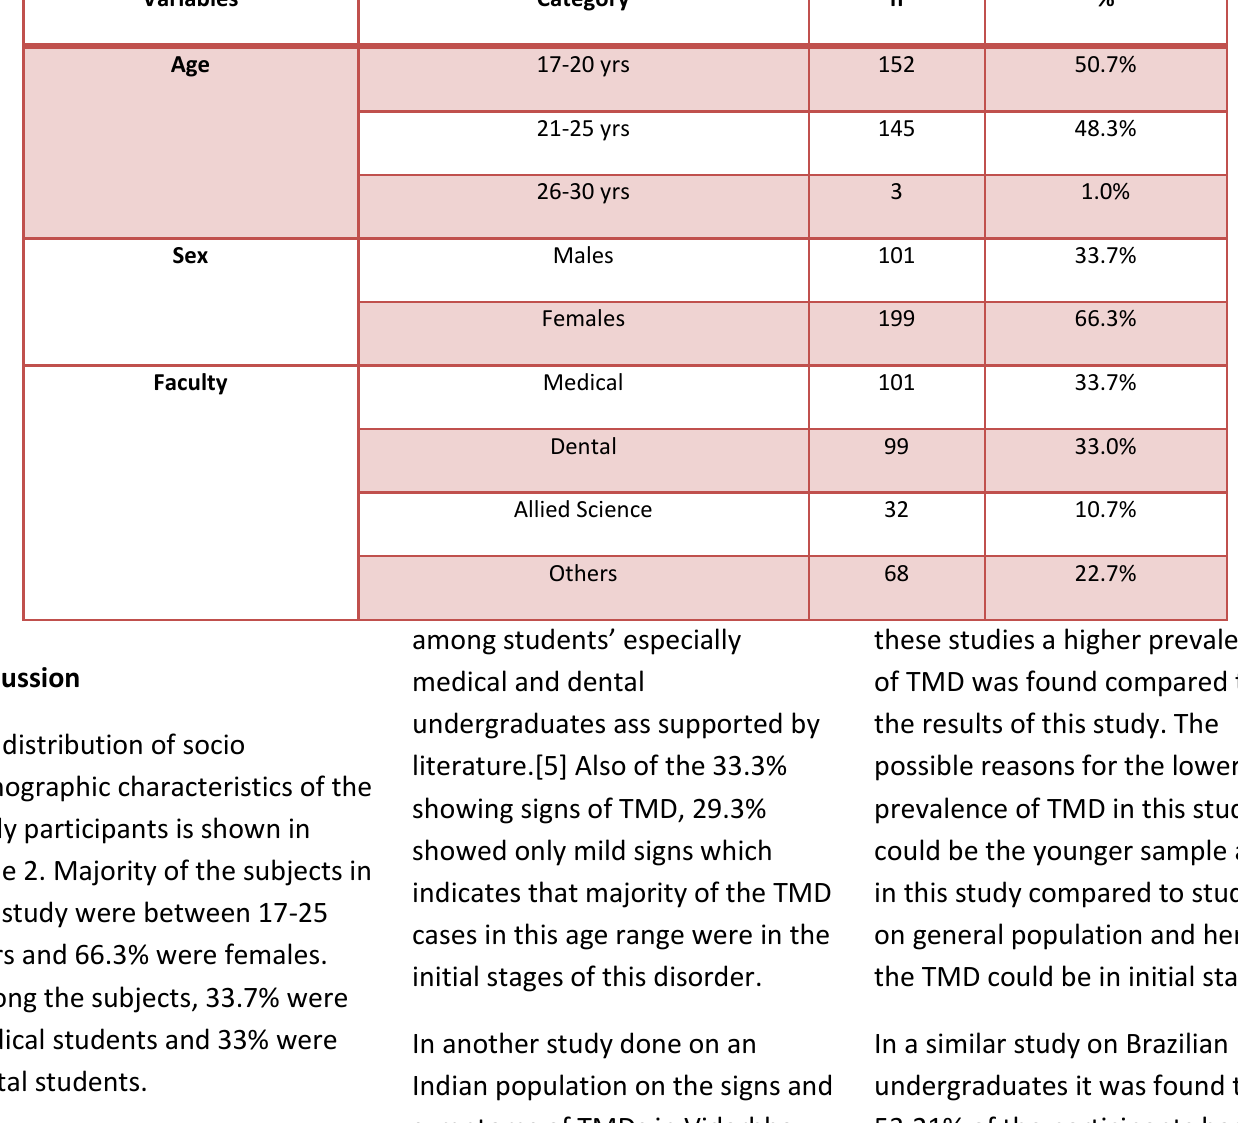
Table 2- Distribution of Socio demographic characteristics of study participants. (others include Business Management, Commerce & Finance